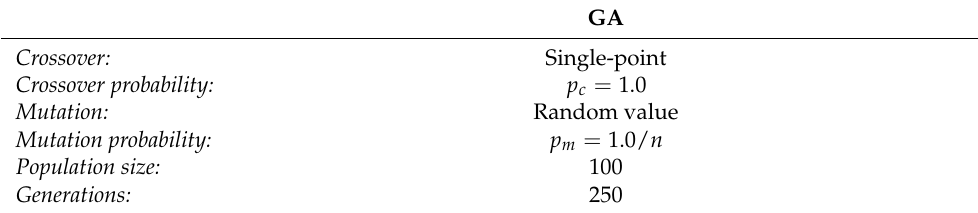
Table 3. Parameter settings for the proposed Genetic